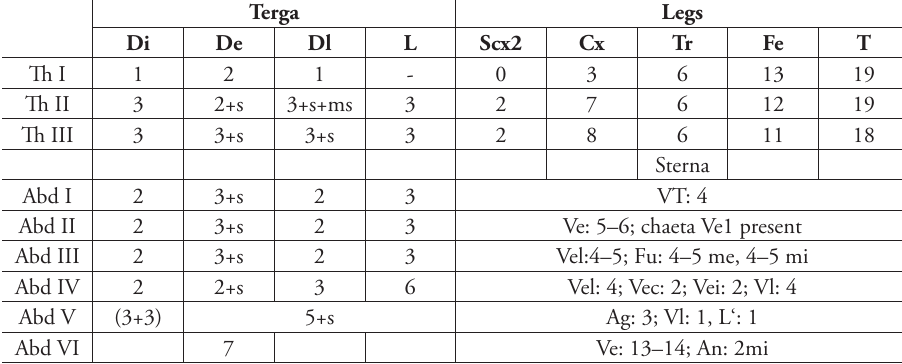
Table 2c. Chaetotaxy of Endonura paracentaurea sp. n.: postcephalic chaetotaxy. Terga